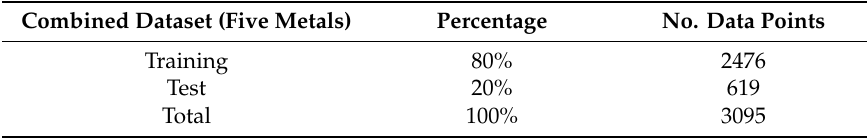
Table 4. Data set statistics (Combined dataset).